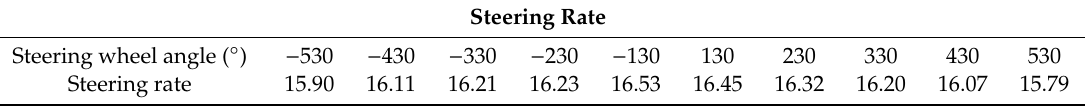
Table 2. Variable steering rate for di ff erent steering wheel angle of the controlled